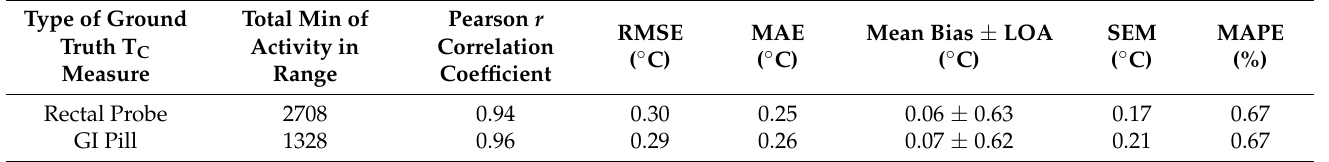
Table 5. Kenzen T C accuracy compared to both gold standard measures of T C